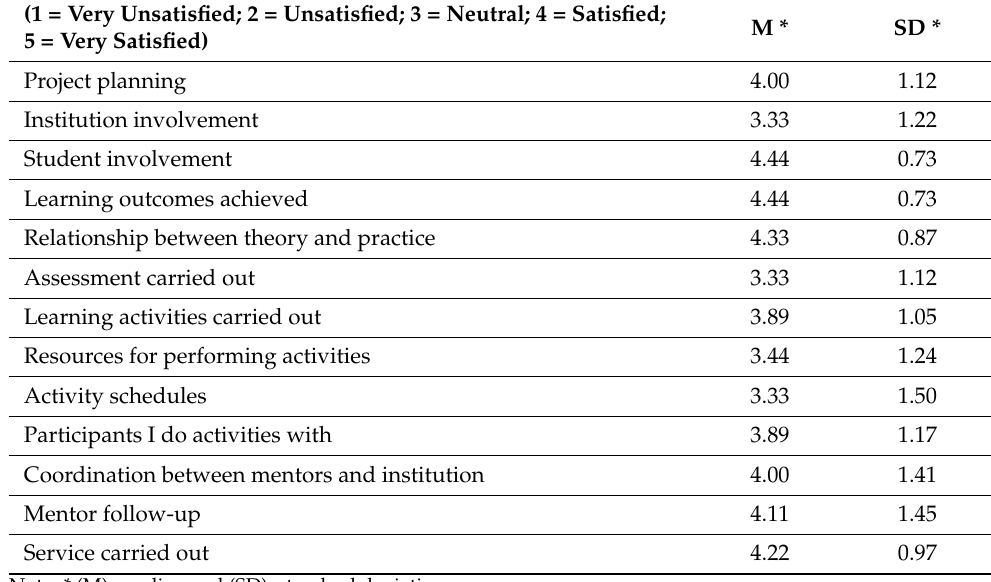
Table 3. Quantitative results: satisfaction rates, Level 2